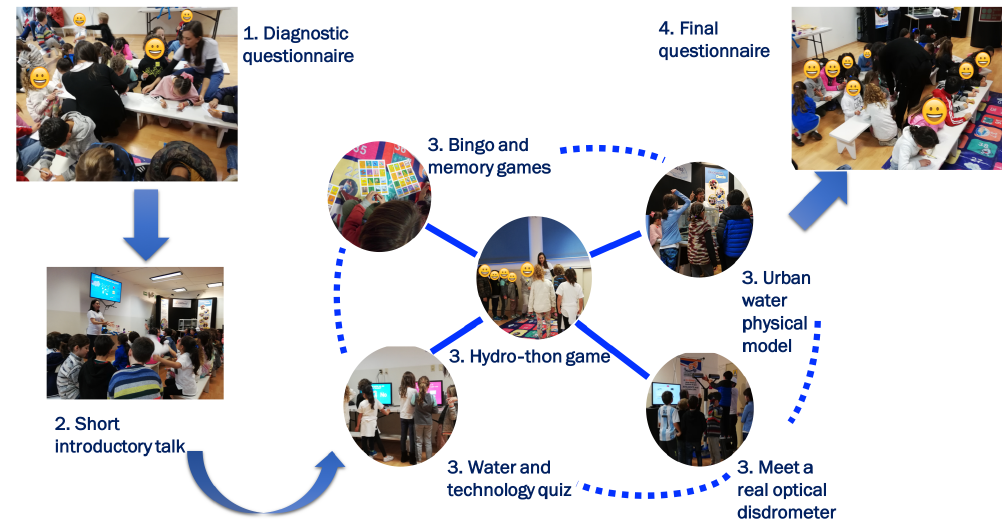
Figure 1. Schematic view of the order of activities performed during the OH-Kids workshop. Table 1. Sequence of OH-Kids workshop activities along with time duration and number of students (italic lines comprise the simultaneous activities of the